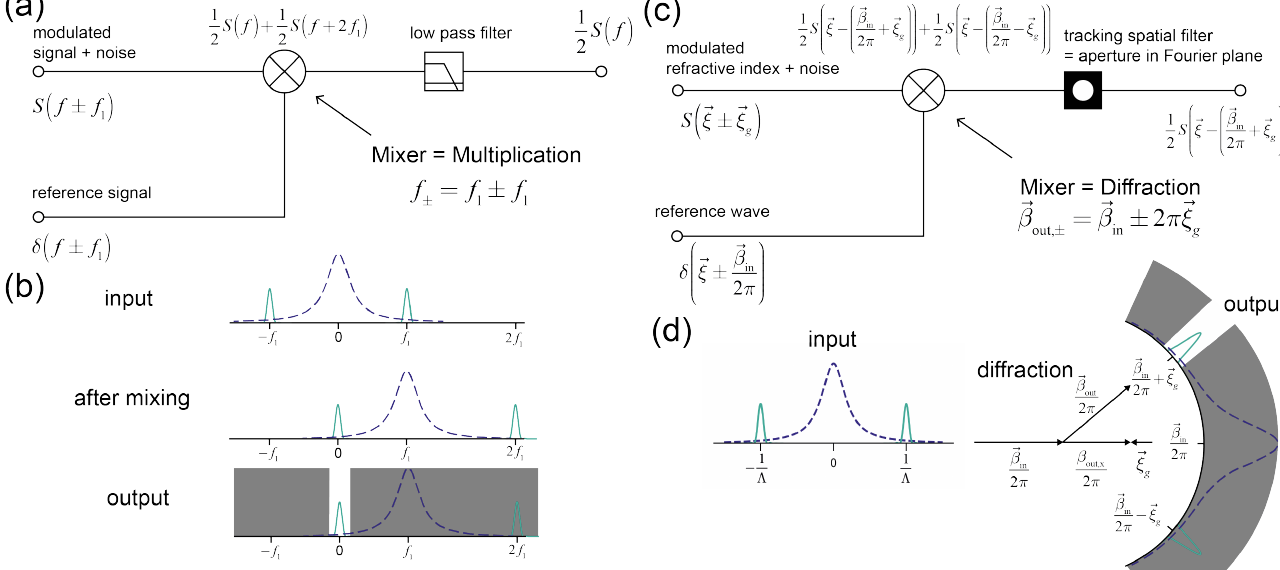
(cid:16) (cid:126) (cid:17) ξ ± (cid:126) ξ g ) and produces